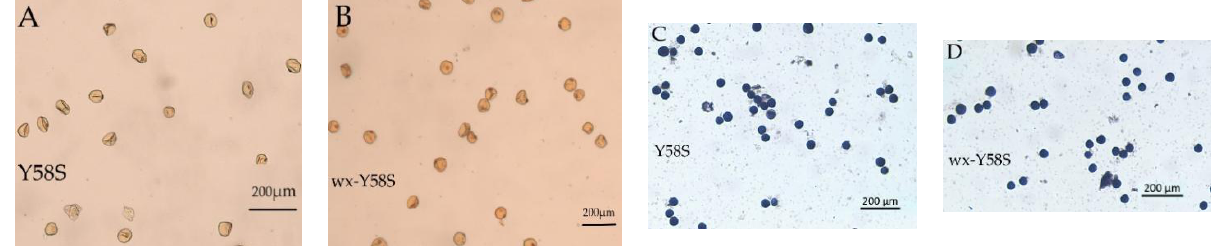
Figure 7. Pollen iodine staining results of Y58S ( A , C ) and wx-Y58S (T 2 line W-1-B-5) ( B , D ). ( A , B ) the normal growth